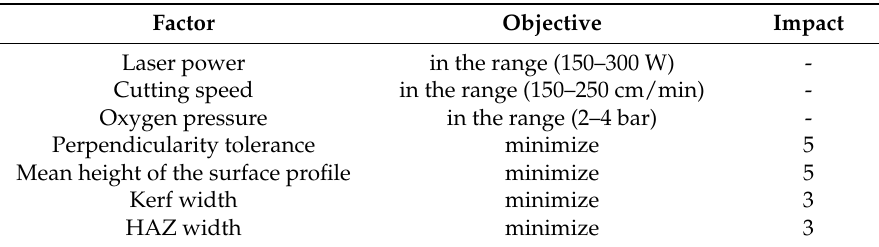
Table 8. Criterion used in the optimization of cut surface quality.